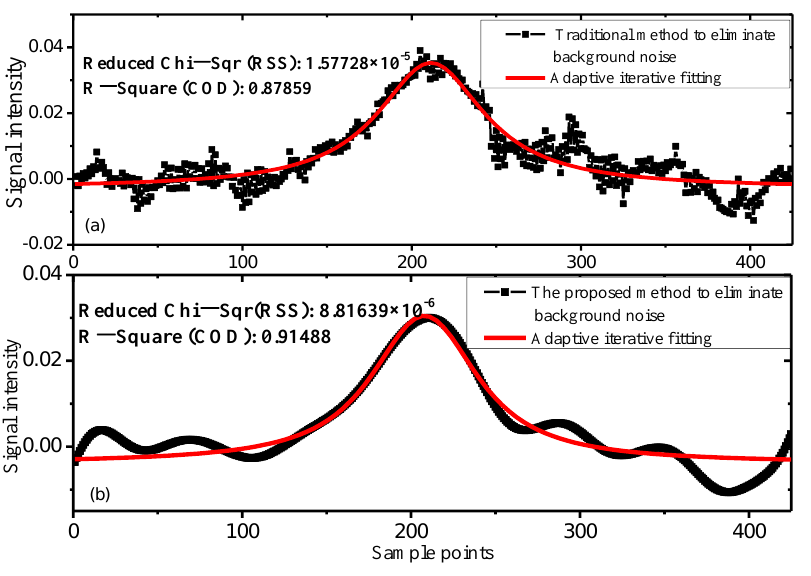
Figure 7. Adaptive iterative fitting.